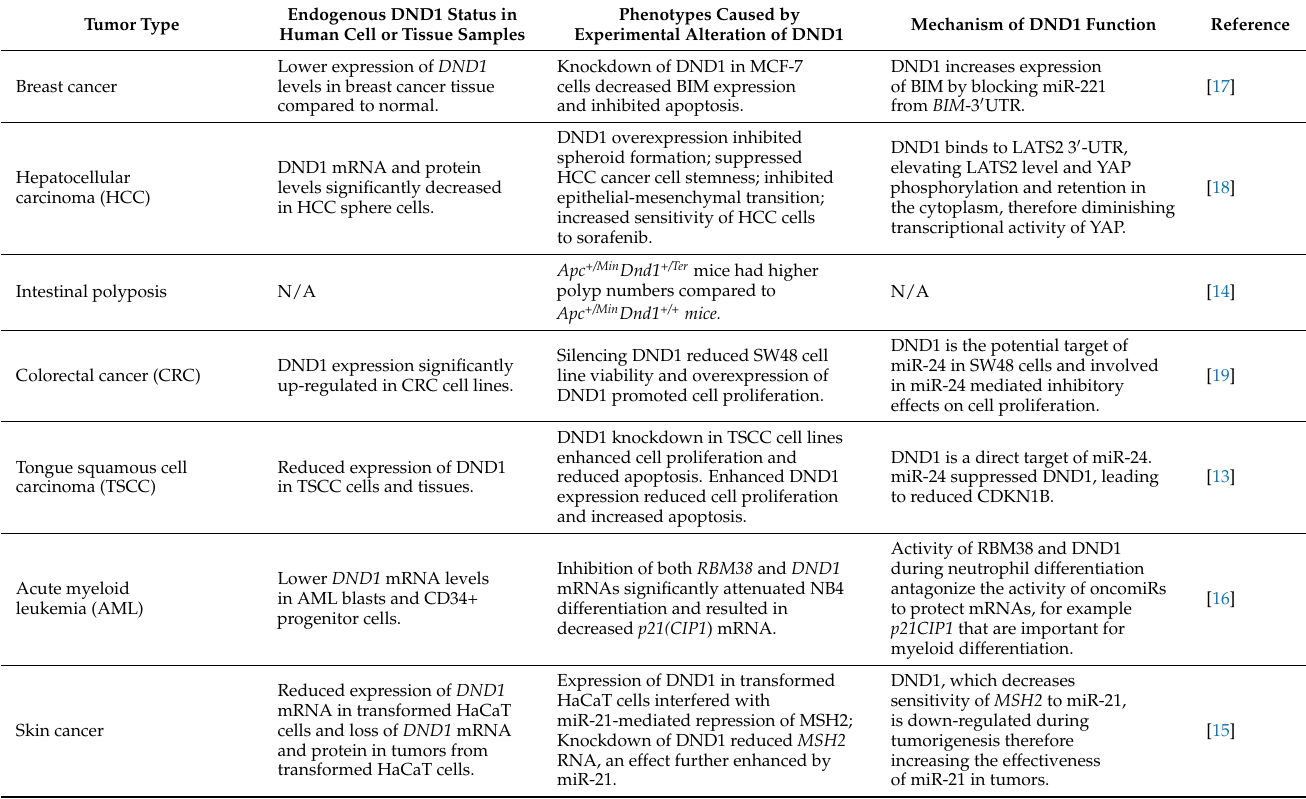
Table 1. Studies on the role of DND1 in somatic